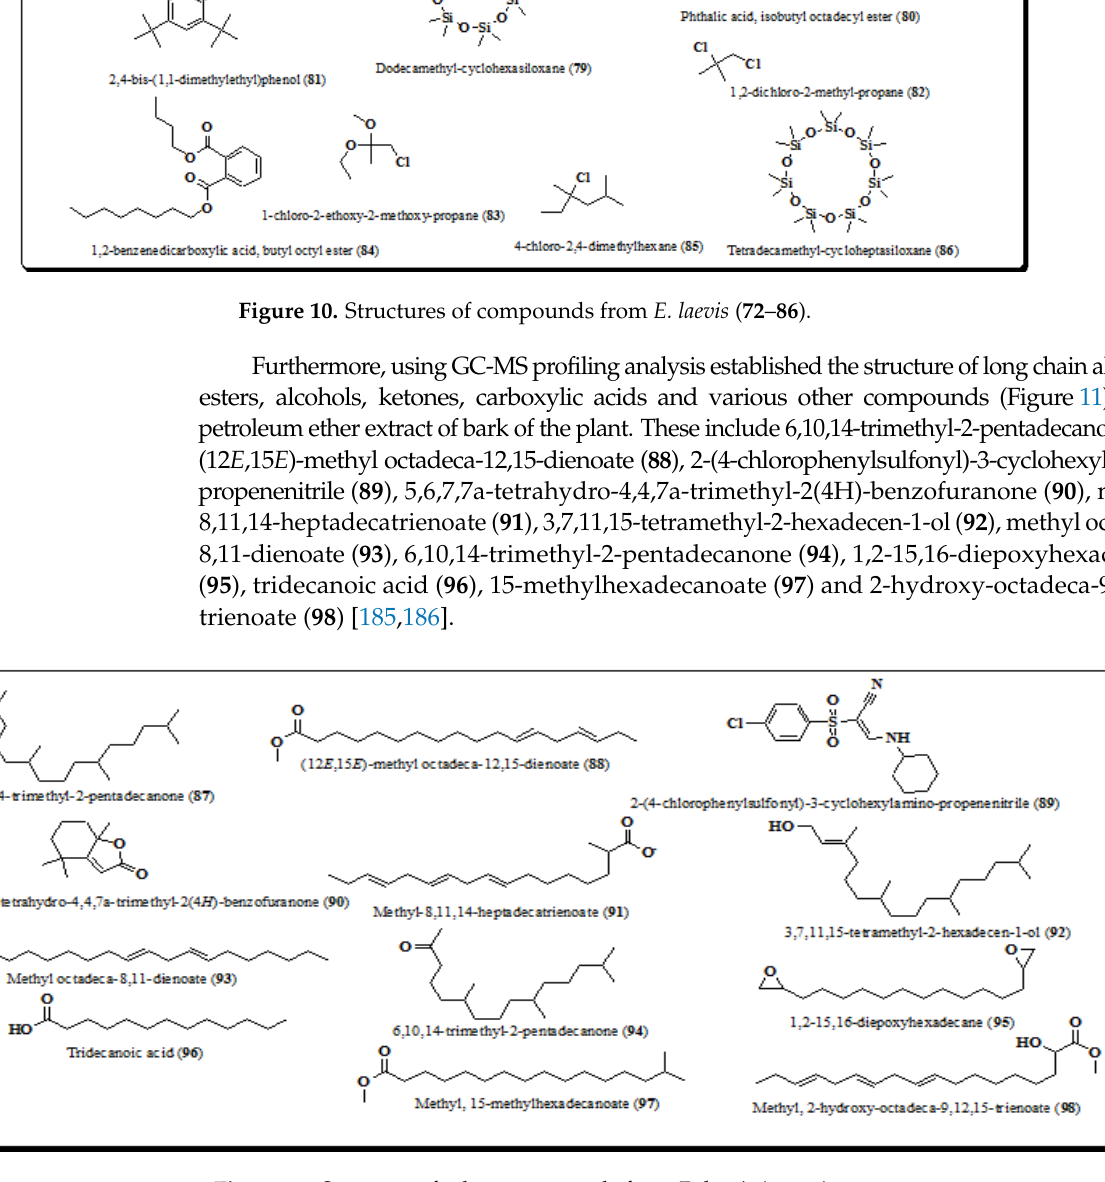
Figure 11. Structure of other compounds from E. laevis ( 87 – 98